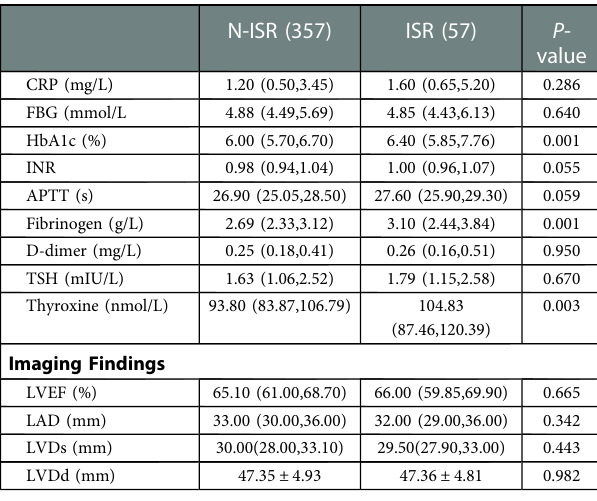
TABLE 1 Baseline characteristics of the study population.